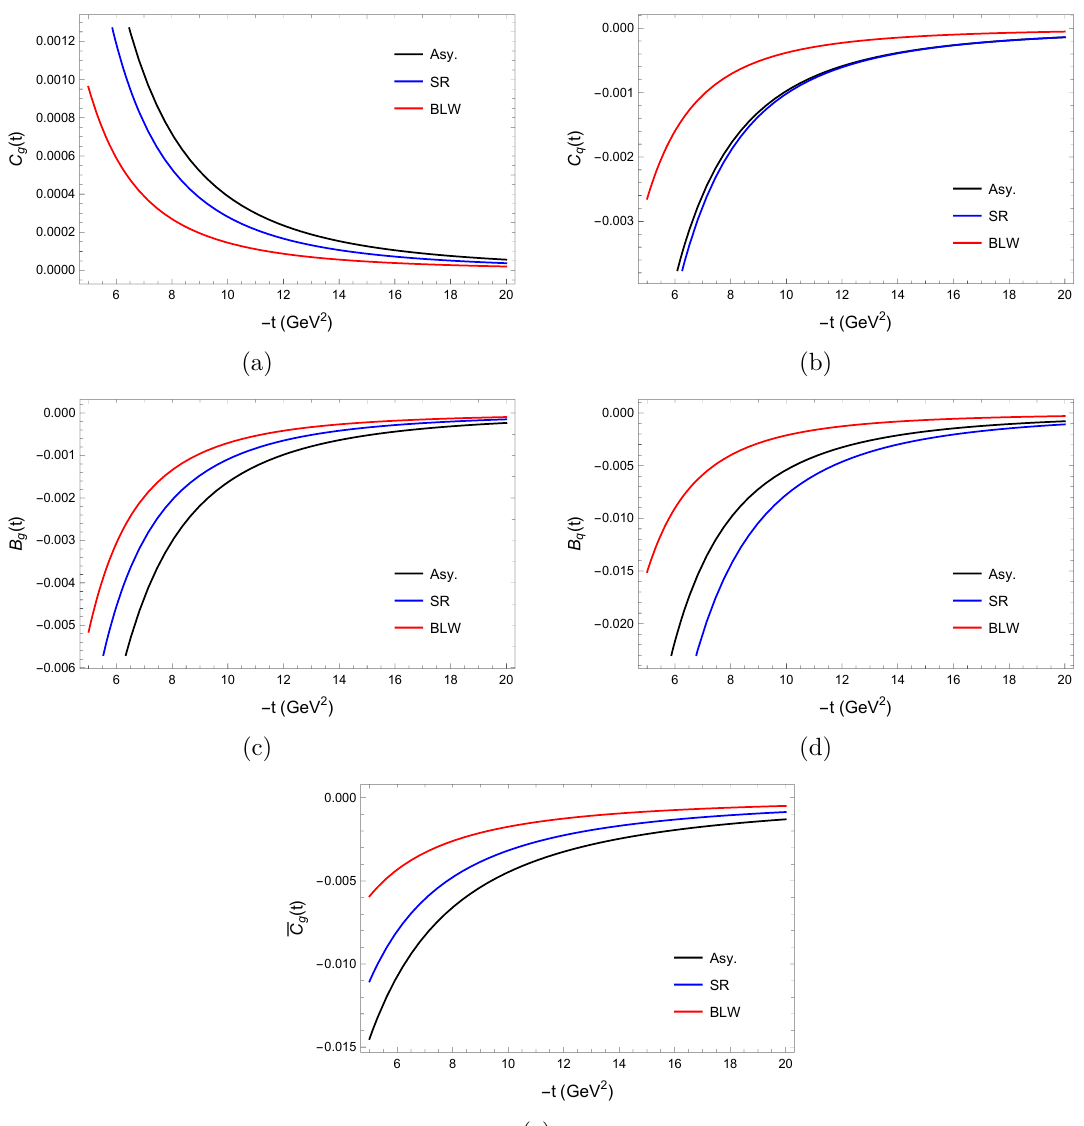
Figure 6. Nucleon GFFs with different estimates or models of nucleon DAs: QCD sum rule(SR) [81, 98], Braun-Lenz-Wittman(BLW) model [98], the asymptotic (Asy.) model. Here we take Λ c = 200